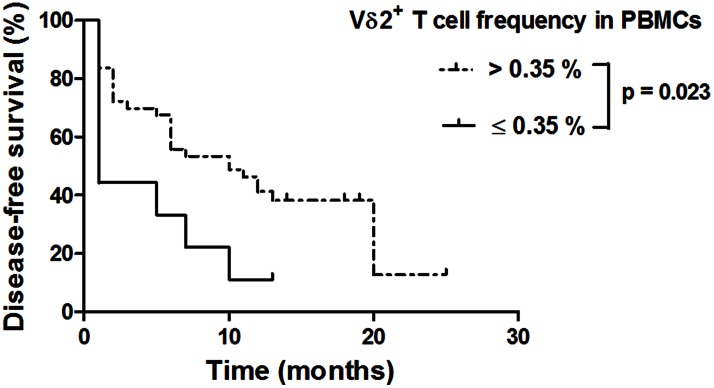
Disease-free survival of chemotherapy-treated EOC patients according to Vγ9Vδ2 cell frequencies among ex vivo PBMCs.Disease-free survival Kaplan-Meier curves of patients with Vγ9Vδ2 cell frequencies in PBMCs of 0.35% or less (≤0.35%) (n = 9) or greater than 0.35% (>0.35%) (n = 43) at the time of blood collection. p value <0.05 indicates a significant difference.